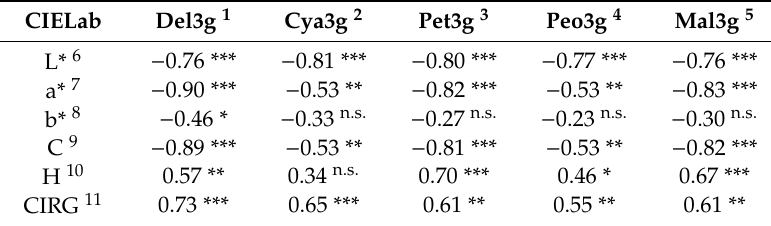
Table 6. Pearson correlation coe ffi cients CIELab color variables (L*, a*, b*, C, h and CIRG) and concentration of individual anthocyanin-3- O -monoglucosides. CIELab Del3g 1 Cya3g 2 Pet3g 3 Peo3g